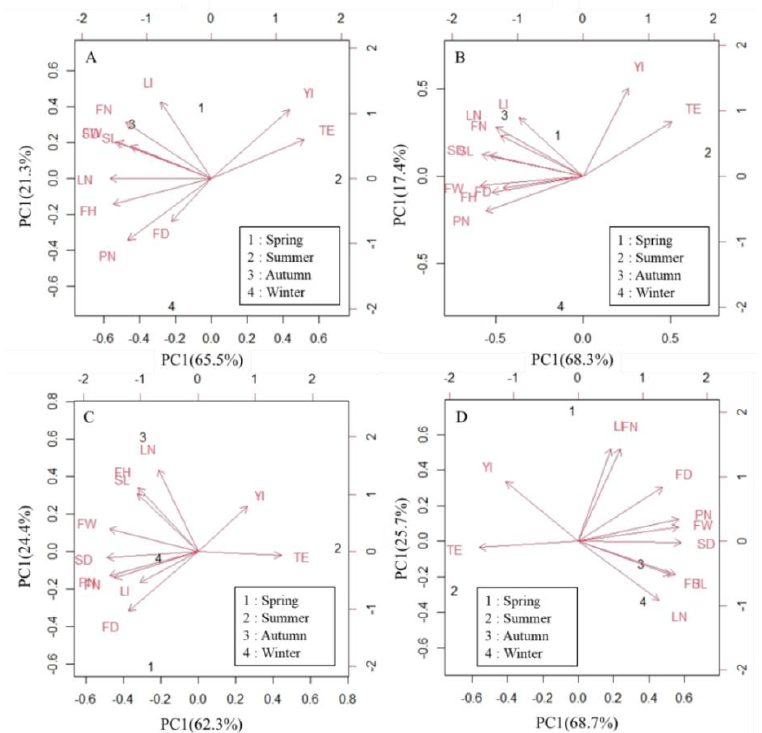
Figure 3. Biplot for the principal component analysis (PCA) of yield and growth on grafted spray type rose Rosa hybrida cv. Pink Shine in four seasons by rootstock type based on the data in Table 2 with the four seasons being identified by numbers 1 to 4 and yield and growth parameter being identified by abbreviation. ( A ): cutting (PS); ( B ): PS grafted onto rootstock of Rosa multiflora cv. Hort.